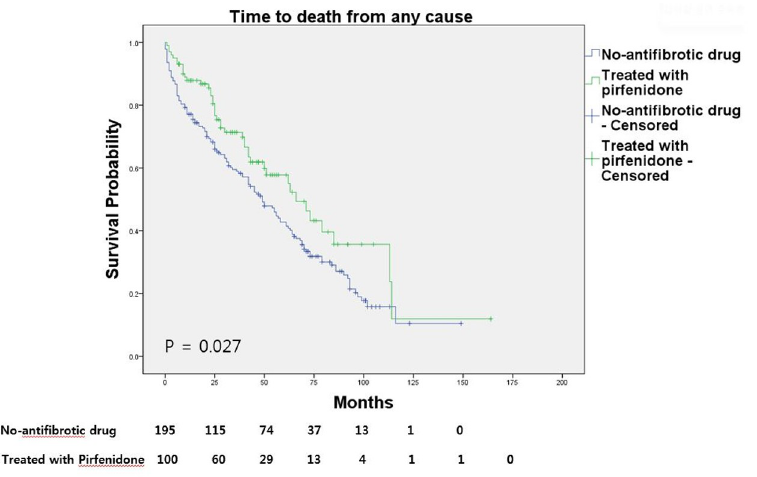
Fig 1. Overall survival of IPF patients on pirfenidone and no-antifibrotic treatment. https://doi.org/10.1371/journal.pone.0261684.g001 The association between pirfenidone treatment and mortality was analyzed (Table 3). Regardless of dose, the mortality rate was significantly lower in patients on pirfenidone (HR = 0.691, 95% CI: 0.484–0.986, p = 0.042). The analysis was repeated after adjusting for age, gender, BMI, and the GAP score; the mortality rate of patients treated with pirfenidone remained significantly lower (HR = 0.563, 95% CI: 0.374–0.845, p = 0.006). There was no sig- nificant association between the dose of pirfenidone (600 or 1200 vs. 1800 mg/day) and mor- tality (HR = 0.865, 95% CI: 0.421–1.779, p = 0.694), including adjusting for age, gender, BMI, and the GAP score (HR = 1.050, 95% CI: 0.472–2.338, p = 0.905).